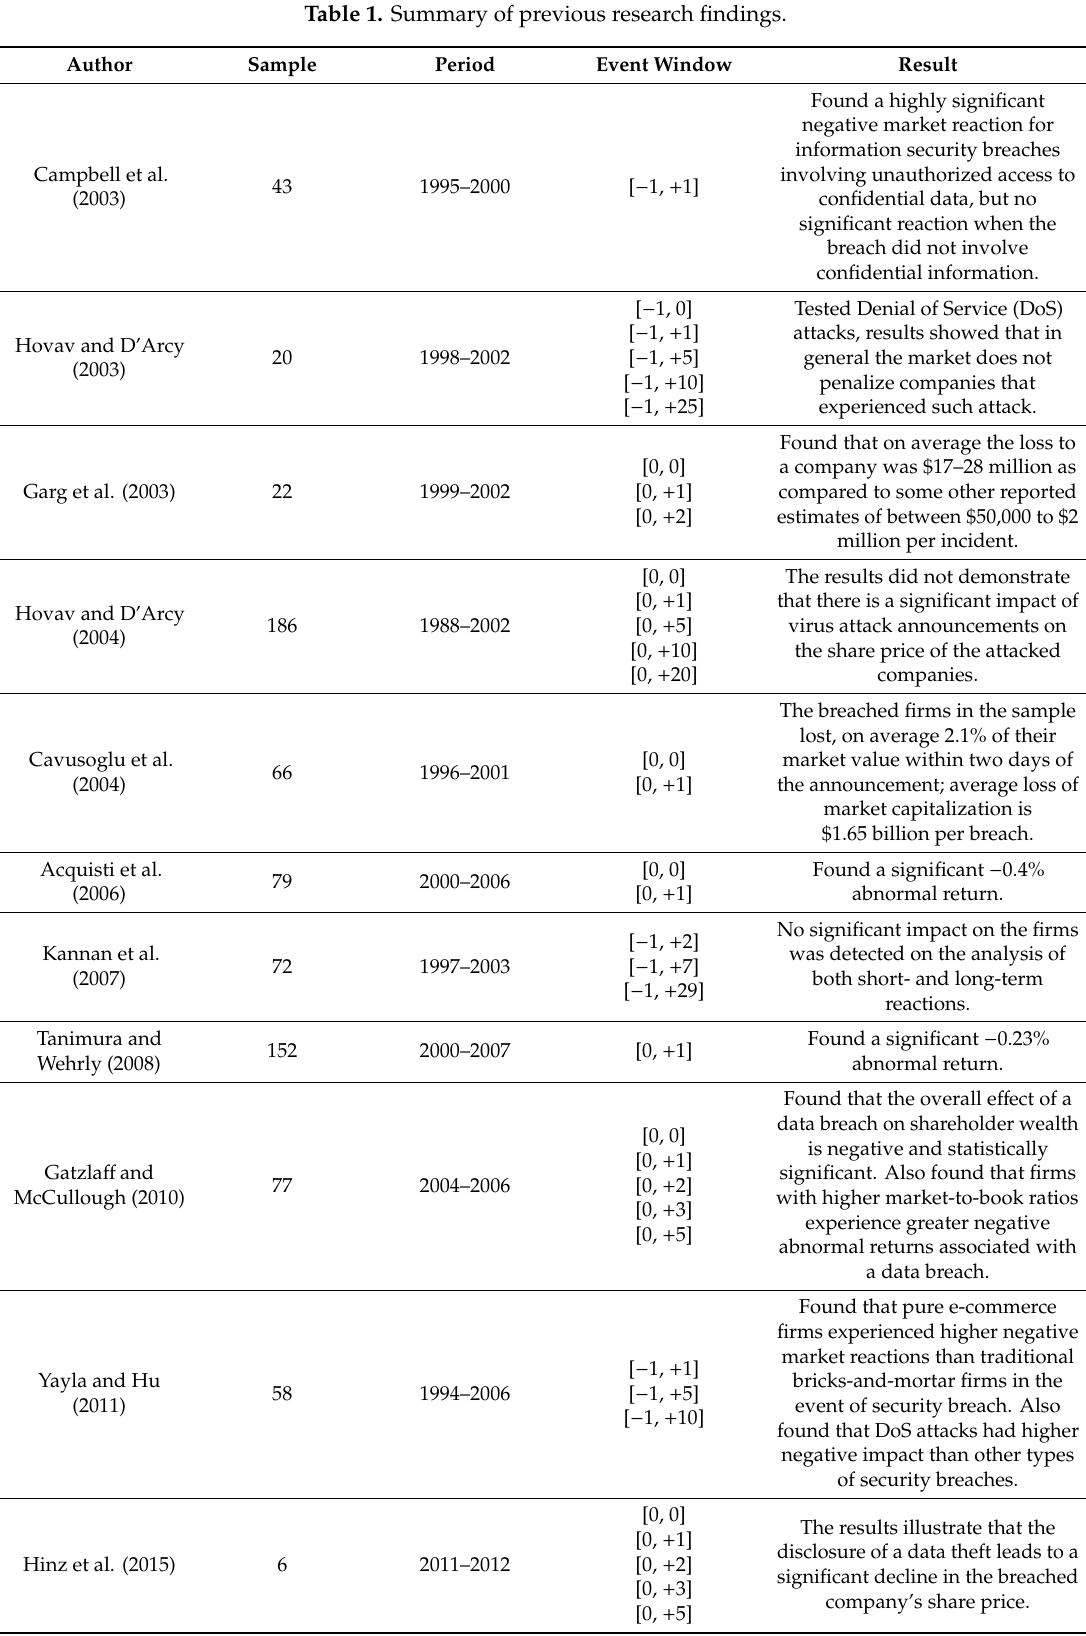
Table 1. Summary of previous research